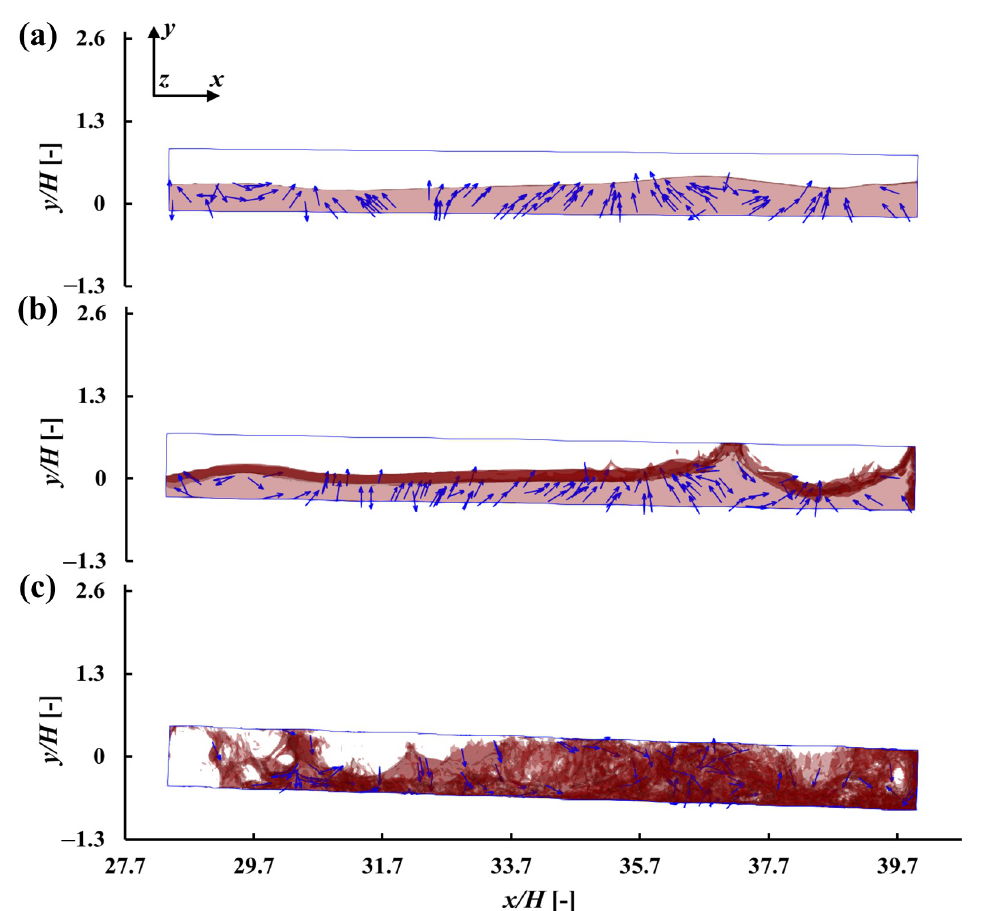
Figure 7. Snapshots for the sloshing tank with N c = 1 at t / T = 2.0 for ( a ) D i = 0.25, ( b ) D i = 0.5 and ( c ) D i = 1.0. Water phase is shown as transparent red with dark red representing the free surface. Blue arrows show the general direction of motion of the sloshing water. The three subplots are points A 0.25 , A 0.5 and A 1.0 , respectively, which are presented in Figure